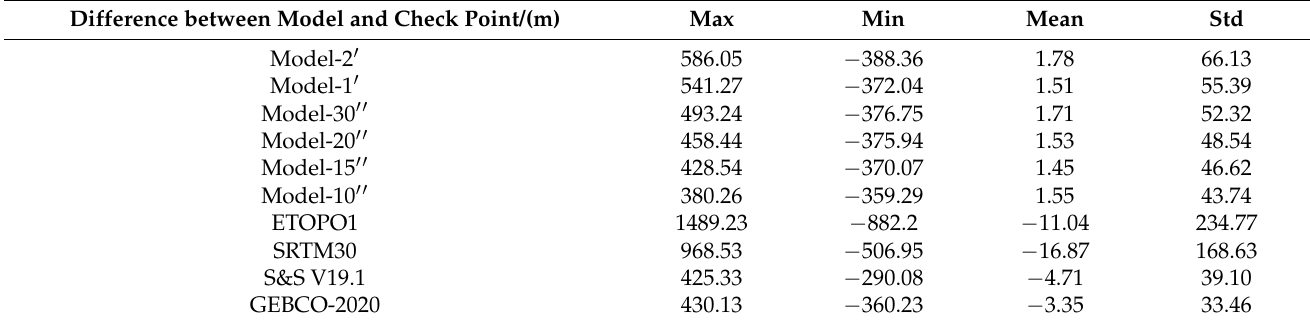
Table 5. Difference data statistics at check points of various topographic models of the Emperor Seamount Chain